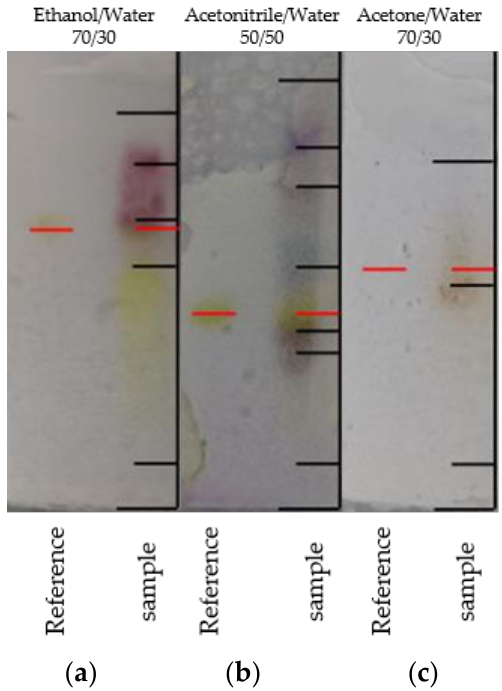
Figure 6. TLC chromatograms of the Nano-Sil CN/UV plate with solvents ( a ) ethanol/water (70/30 vol %), ( b ) acetonitrile/water (50/50 vol %), and ( c ) acetone/water (70/30 vol %).